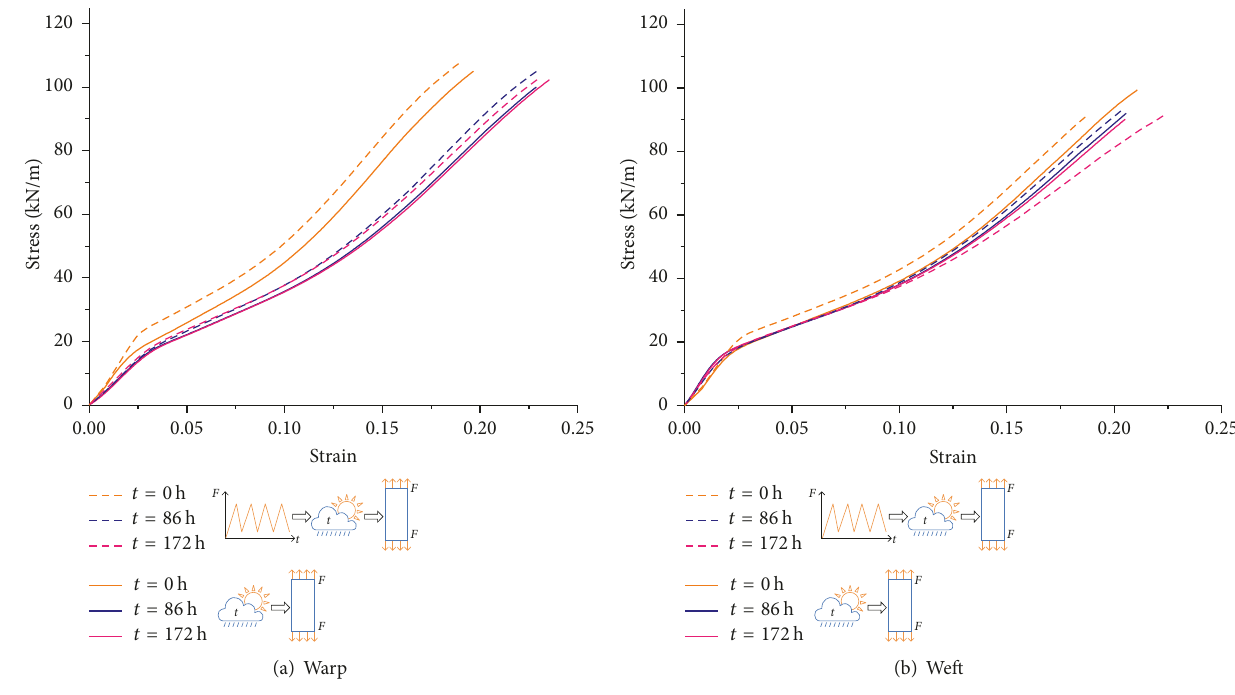
Figure 7: Tensile curves of aging materials (with or without cyclic loading).